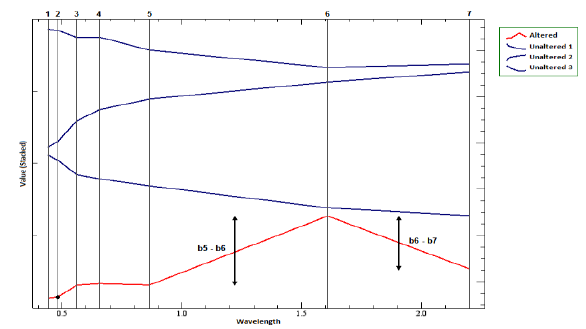
Figure 2. Reflectance spectra of altered and unaltered rock samples gattered from Shahr-e-Babak area.